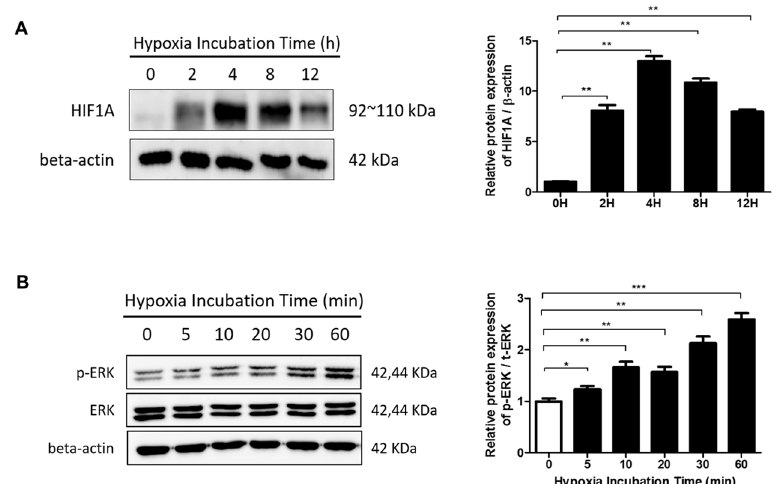
Figure 3. The e ff ects of hypoxia on HIF-1 α activation and extracellular signal-related kinase (ERK) phosphorylation in HDFs were analyzed by Western blot. ( A ) HIF-1 α protein levels were increased in HDFs cultured under hypoxia for the indicated times. Data are shown as mean ± SD. ** p < 0.01 ( B ) Phosphorylation levels of ERK under hypoxia were assessed. Graphs show the optical density ratios between the bands representing the phosphorylated and total protein. Data are shown as mean ± SD. * p < 0.05, ** p < 0.01, *** p < 0.001.